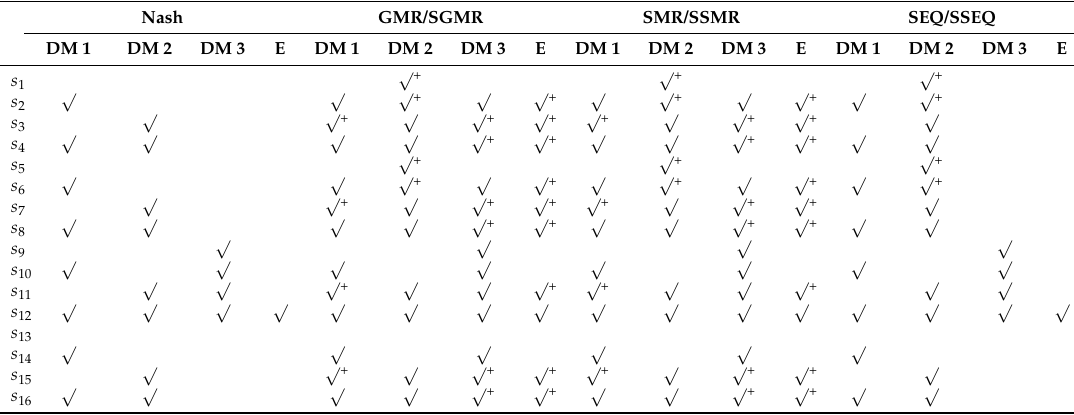
Table 7. Stability analysis